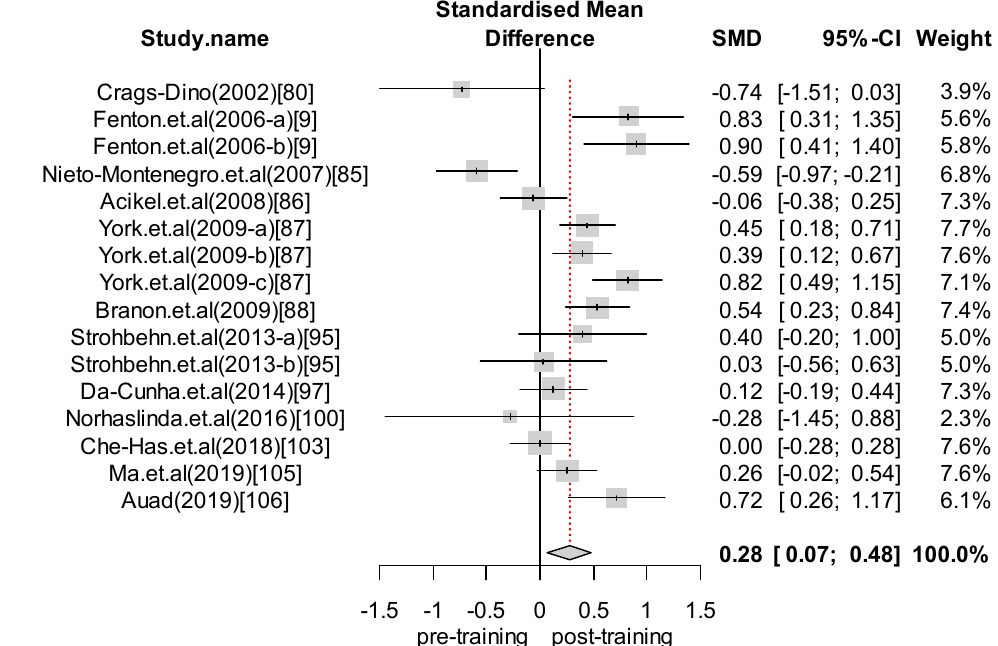
Figure 3. Forest Figure 3. Forest plot—Attitude.